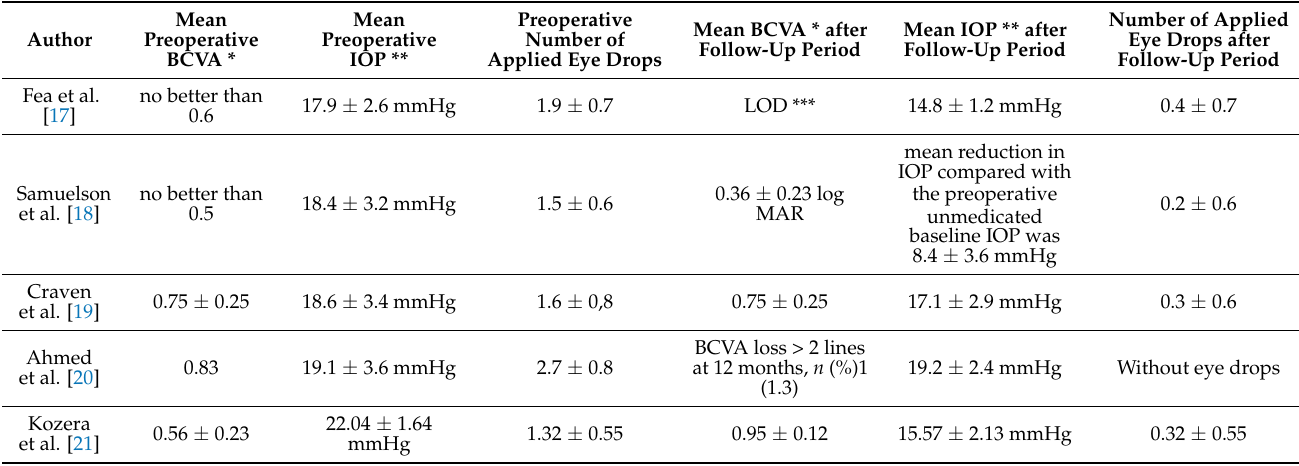
Table 3. Mean pre- and postoperative values of best corrected visual acuity, intraocular pressure, and number of antiglau- coma medications used before and after iStent implantation.